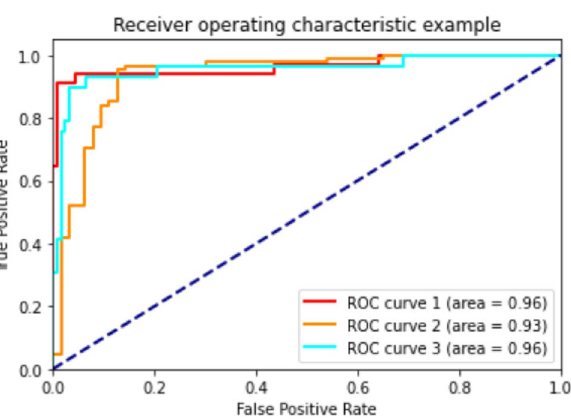
Figure 3. AUROC in GB algorithm for predicting healthy, osteopenia, and osteoporosis in